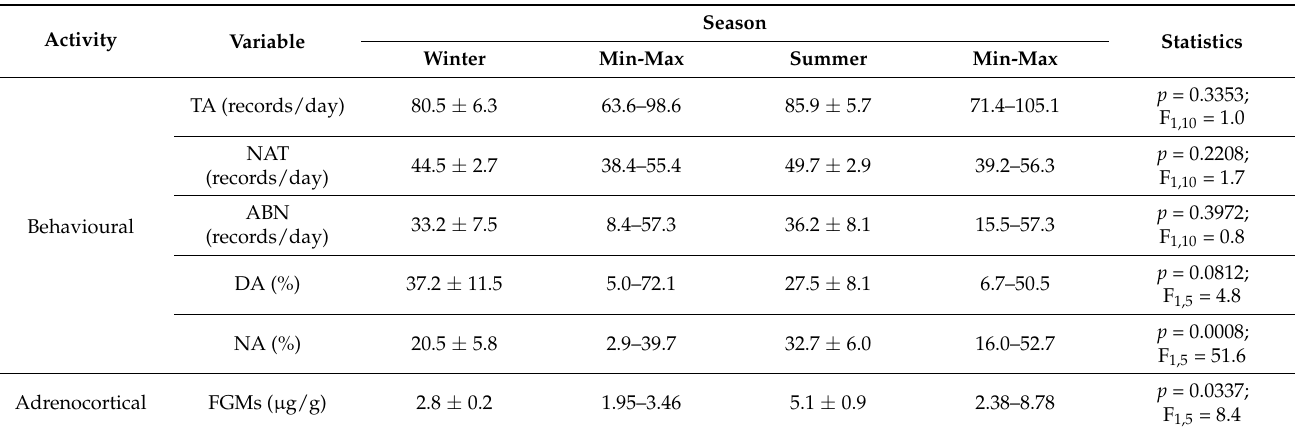
Table 1. Behavioural and adrenocortical activity in adult Tamandua tetradactyla individuals exposed to semi-controlled conditions during winter and summer.